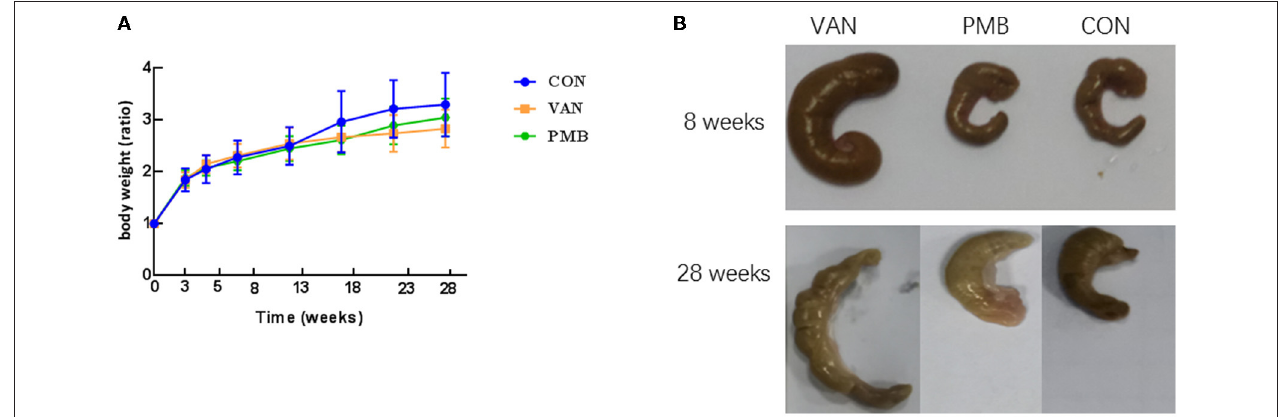
FIGURE 2 | Effect of antibiotic treatment on mouse growth performance and gut phenotype. (A) Time curve of body weight ratio changes at different time points. (B) The caecum of mice with antibiotics-treated for 8 and 28 weeks. VAN, vancomycin; PMB, polymyxin B; CON,